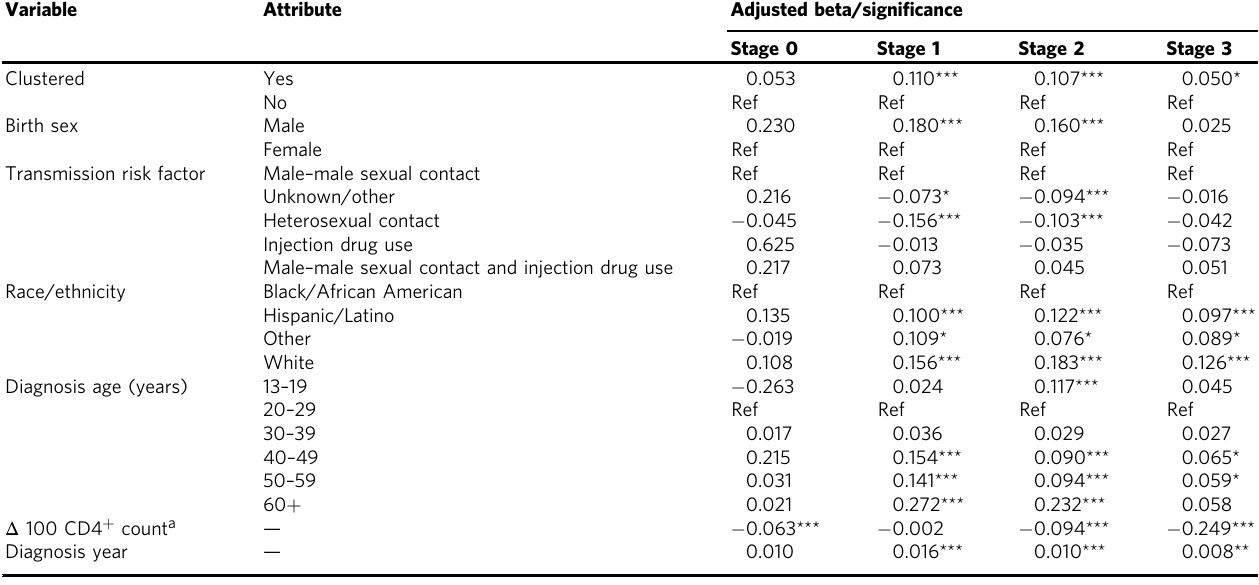
Table 2 Relationship between attributes and viral load in the multivariate linear regression analysis for individuals with wild- type virus in the inferred molecular transmission network, strati fi ed by stage of infection at diagnosis, United States.